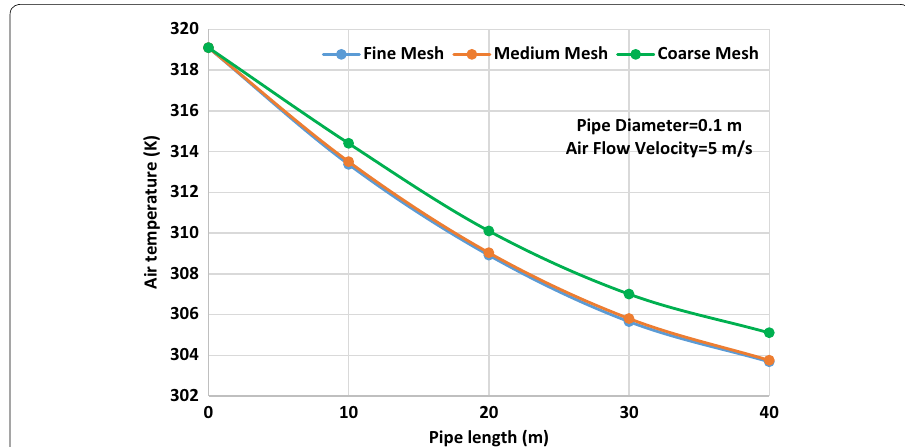
Fig. 3 Grid independence test: air temperature variation along the length of pipe for fine, medium and coarse mesh